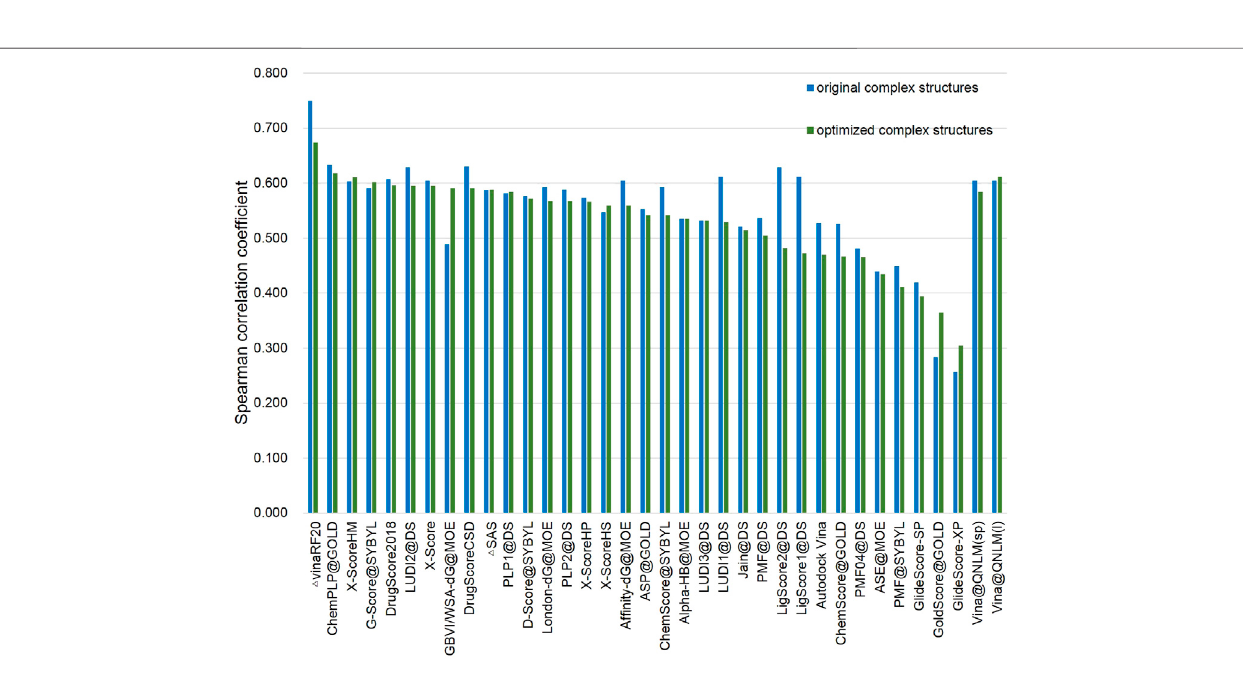
Accordingly, the Spearman rank correlation coef fi cient is shown in Figure 8 ; Supplementary Tables S8, S9 . Vina@QNLM scoring function ranked fourth and fi fth, and its Spearman's rank correlation coef fi cient was 0.616 and 0.604 in the single-point